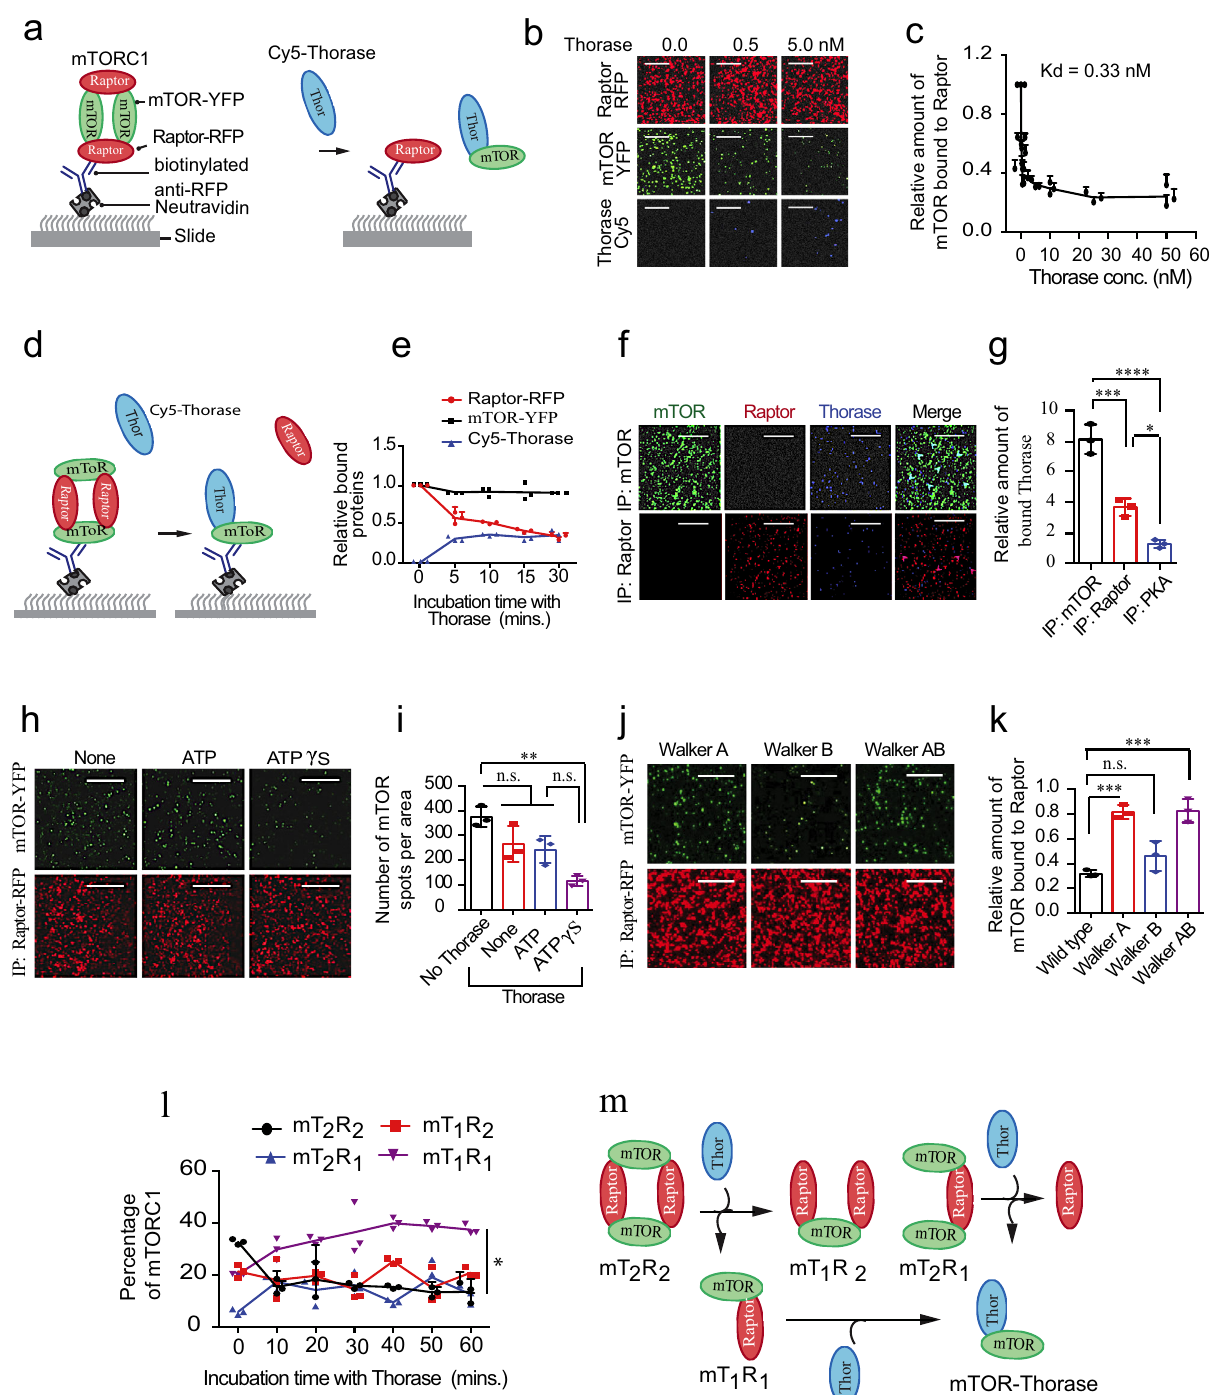
Fig. 2 | Thorase disassembles the mTOR complex 1 (mTORC1). a Schematic depictionofmTORC1SiMPullinthepresenceofThorase.AdaptedfromJainetal. 28 . b Representative images from SiMPull shown in a with different concentrations of Thorase.Scalebarsare10 μ m. c GraphicalrepresentationofthekineticsofThorase disassembly of mTOR-Raptor complex with a Kd value of 0.33nM. d Schematic diagram of mTOR-Pulldown via SiMPull showing Thorase binds to mTOR upon disassembly of Raptor from mTORC1. Adapted from Jain et al. 28 . e Graphical representation of Raptor (red) disassociation from mTOR and Thorase (blue) binding to mTOR over time ( n =3 independent SiMPull assays, Thorase-Cy5 values 5x). f Representative images of SiMPull binding analyses showing that Thorase has higher af fi nity for mTOR than Raptor. Scale bars are 10 μ m. g Graphical repre- sentation of quanti fi ed intensities from images in f . h Representative images of